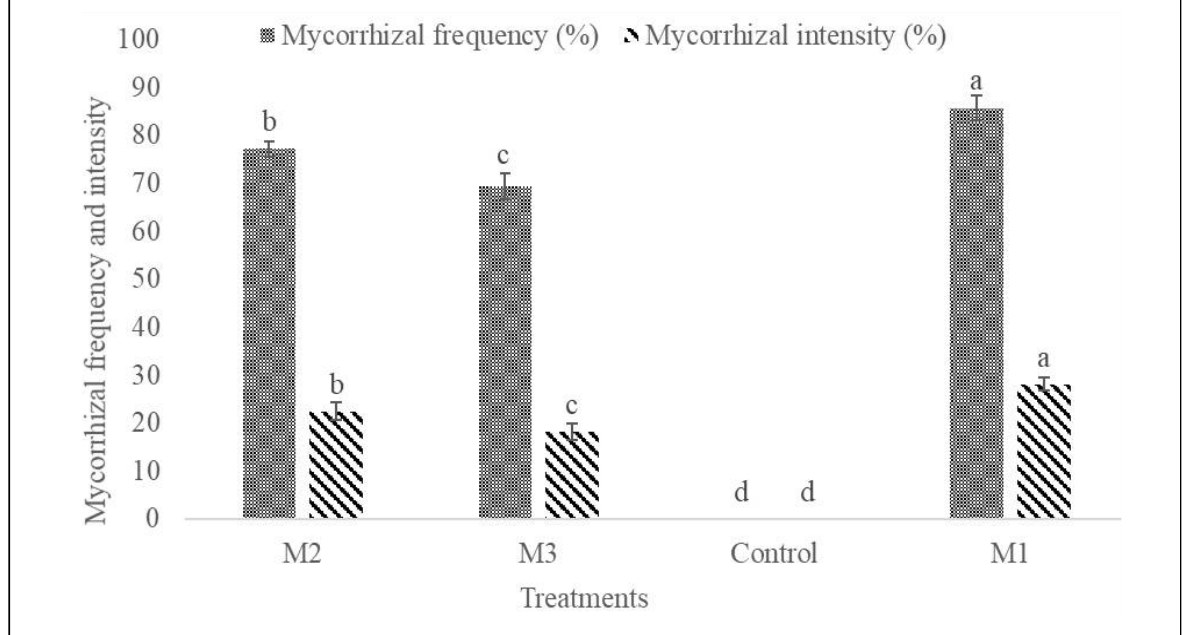
Figure 1: The mycorrhizal frequency and intensity of Sclerocarya birrea plants inoculated or not with (M1, M2 and M3) Note: Values of the same parameter (mycorrhizal frequency or intensity) with the same letter are not significantly different according to the Newman-Keuls test ( p < 0.05); Significance level for mycorrhizal frequency and intensity ( p < 0.0001); and Standard error of the mean ( n =